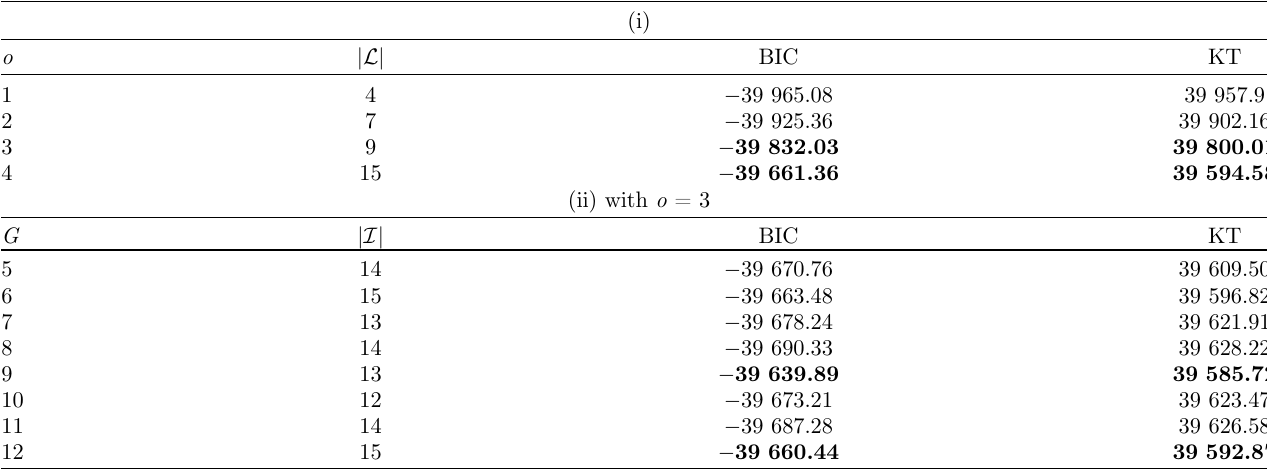
Table 6. On top, settings under the perspective (i): memory o , cardinal of partition | L |, BIC and KT values. On bottom, settings under the perspective (ii): parameter G , cardinal of partition | I |, BIC and KT values. In bold letter the 2 best